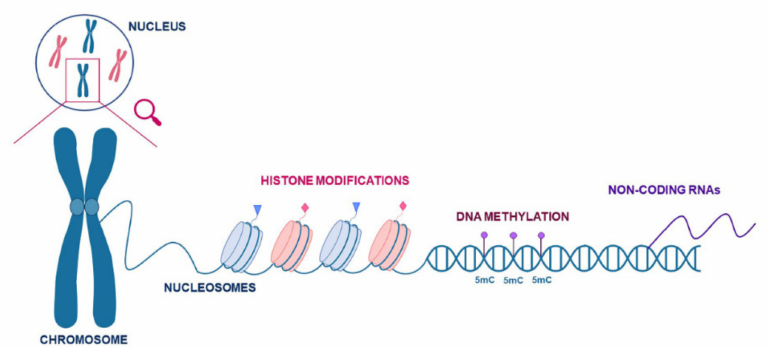
Figure 1. Schematic representation of the main epigenetic mechanisms: DNA methylation, histone post-translational modifications (PMTs) and non-coding RNAs. In the nucleus, chromatin is organised in peculiar chromosome structures composed of DNA wrapped around nucleosomes. Nucleosomes are formed by four histones that can be modified in their N -terminal tails to open or compact chromatin, for example, acetylation, phosphorylation and methylation. DNA methylation usually occurs at 5 (cid:48) -position cytosine residues on CpG islands. Non-coding RNAs can be transcribed but not translated in a protein playing a crucial role in epigenetic regulation of the genome. All epigenetic modifications work together to determine an epigenetic code to regulate chromatin organisation and gene